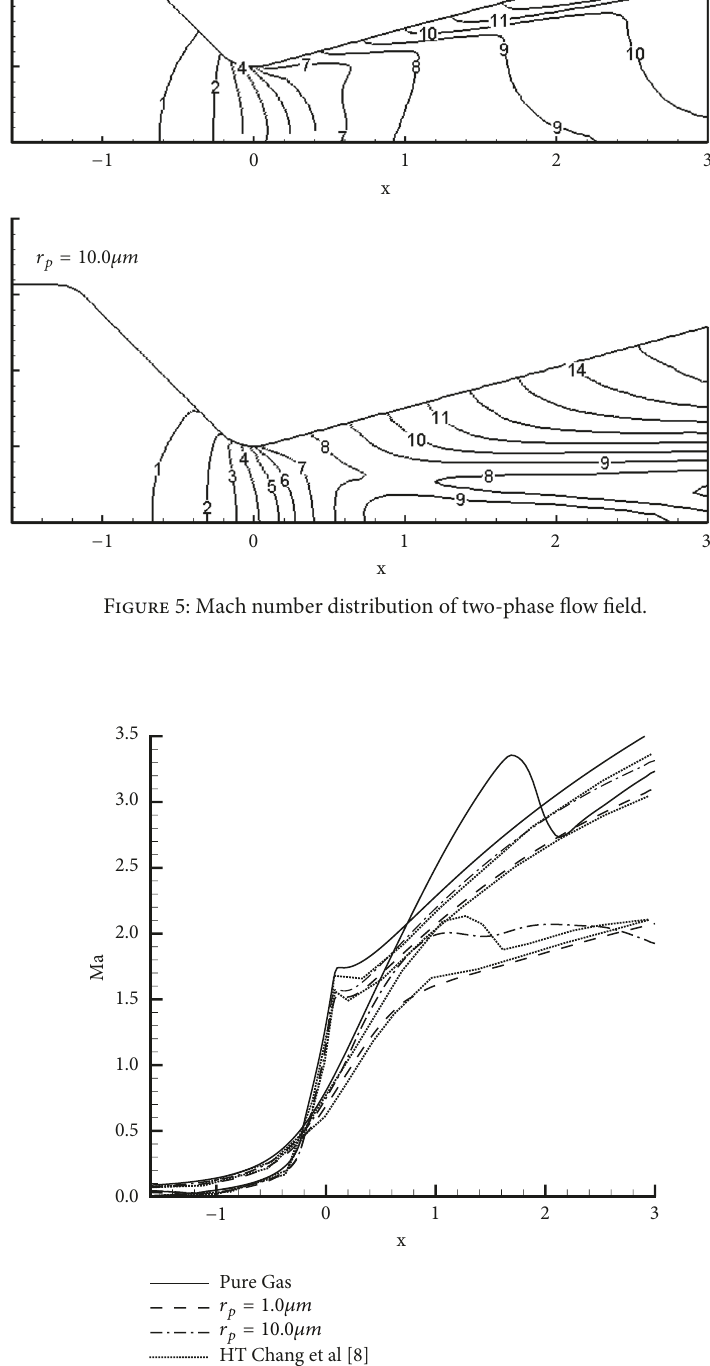
Figure 6: Mach number profiles of two-phase